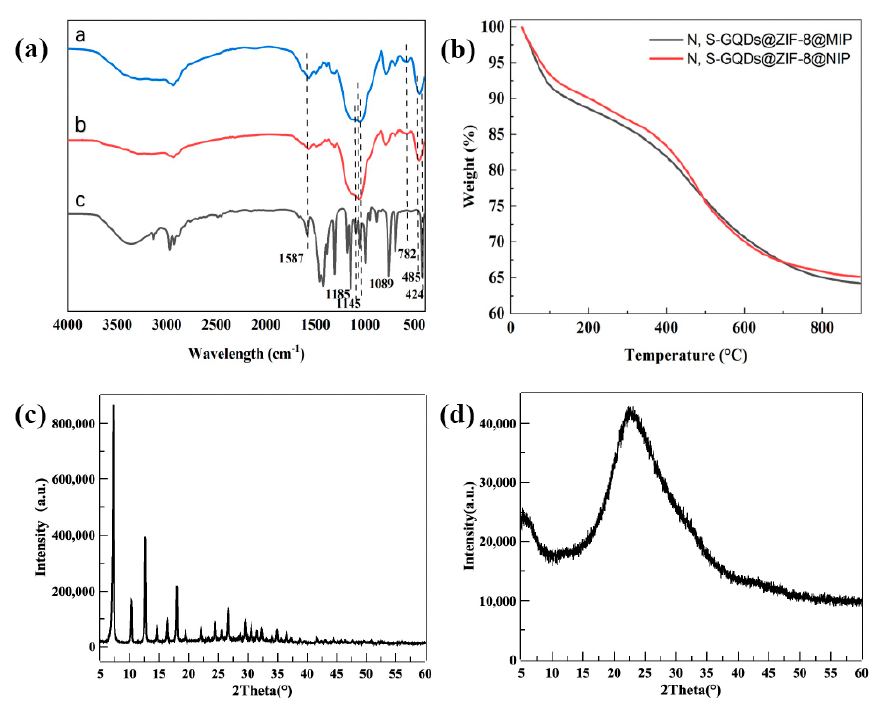
Figure 2. ( a ) FT-IR spectra of N, S-GQDs@ZIF-8@MIP-a, N, S-GQDs@ZIF-8@NIP-b, and ZIF-8-c. ( b ) TGA curves of N, S-GQDs@ZIF-8@MIP and N, S-GQDs@ZIF-8@NIP. XRD curves of ZIF-8 ( c ) and N, S-GQDs@ZIF-8@MIP ( d ).